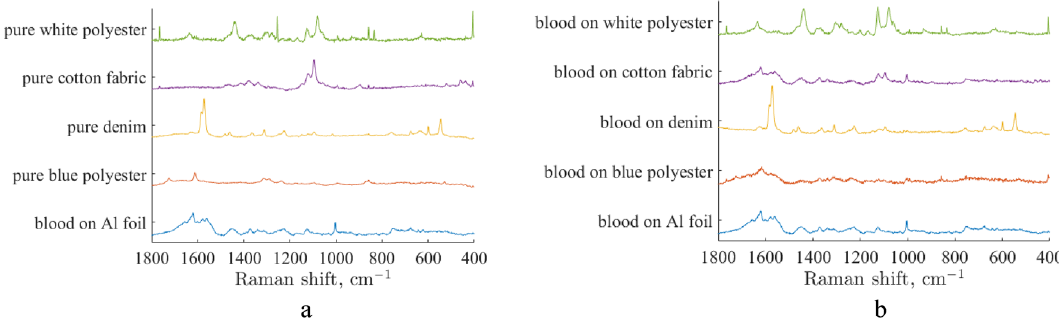
Figure 3. Selected Raman spectra of pure blue polyester, denim, cotton fabric, and white polyester substrates ( a ) and the bloodstains on Al foil on the same pure substrates ( b